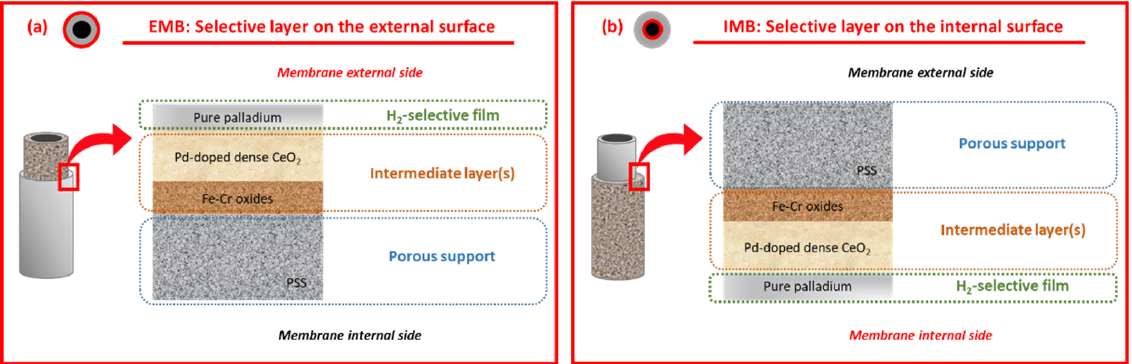
Figure 1. Schematic structure of composite membranes: selective layer on the external ( a ) or the internal ( b ) surface or tubular PSS supports.